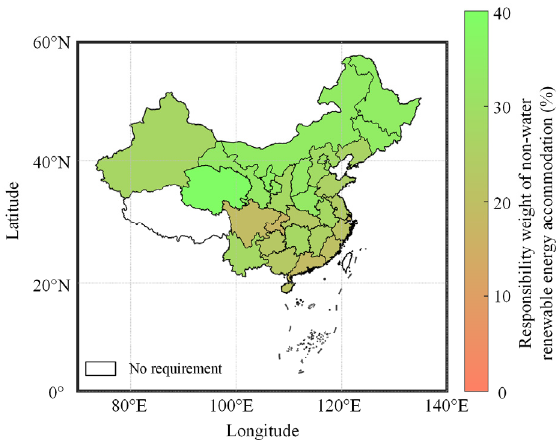
Figure 8. Target RWNWREA of China in